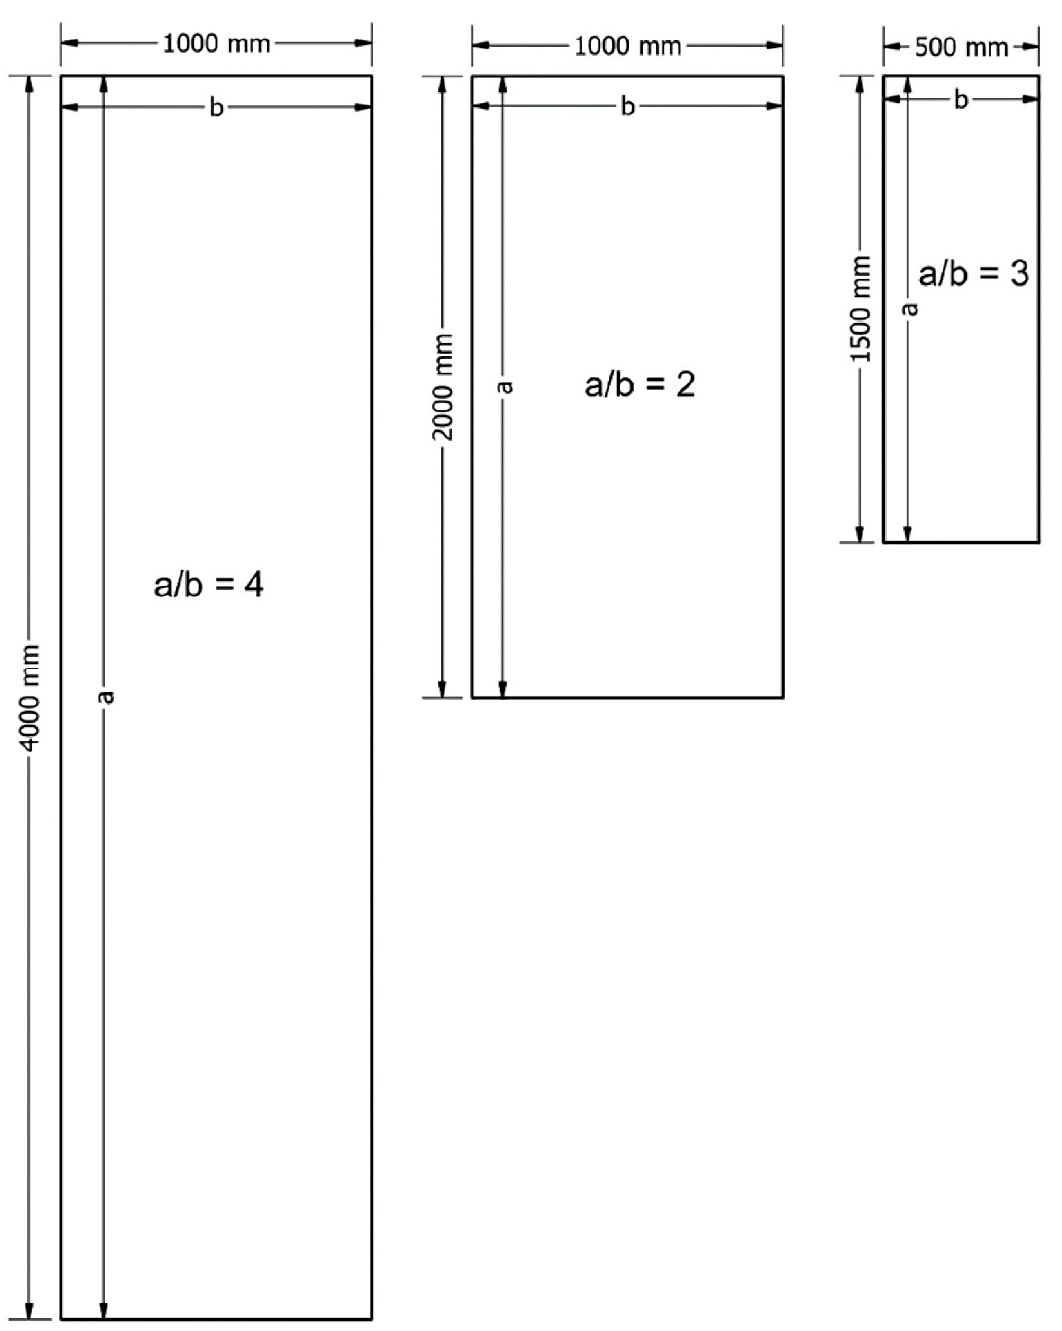
Figure 10. Geometrical design of specimens with three different aspect ratio a / b and three different thickness h .